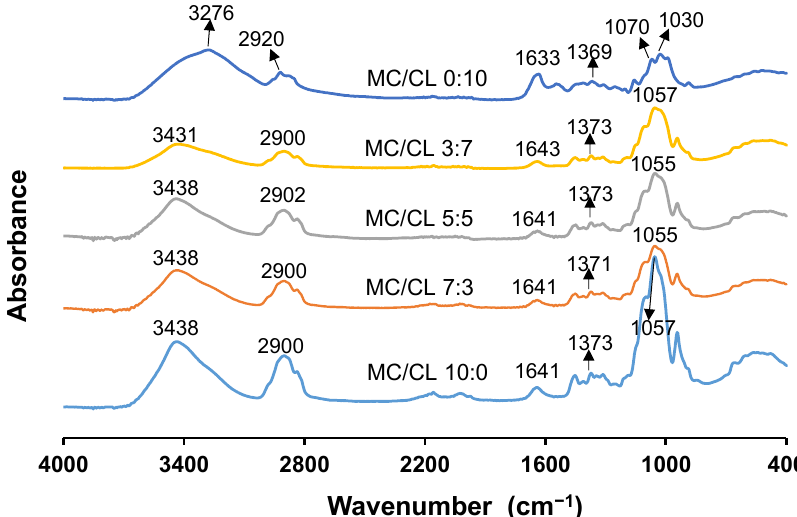
Figure 1. FTIR spectra of MC/CL films with different blend ratios.